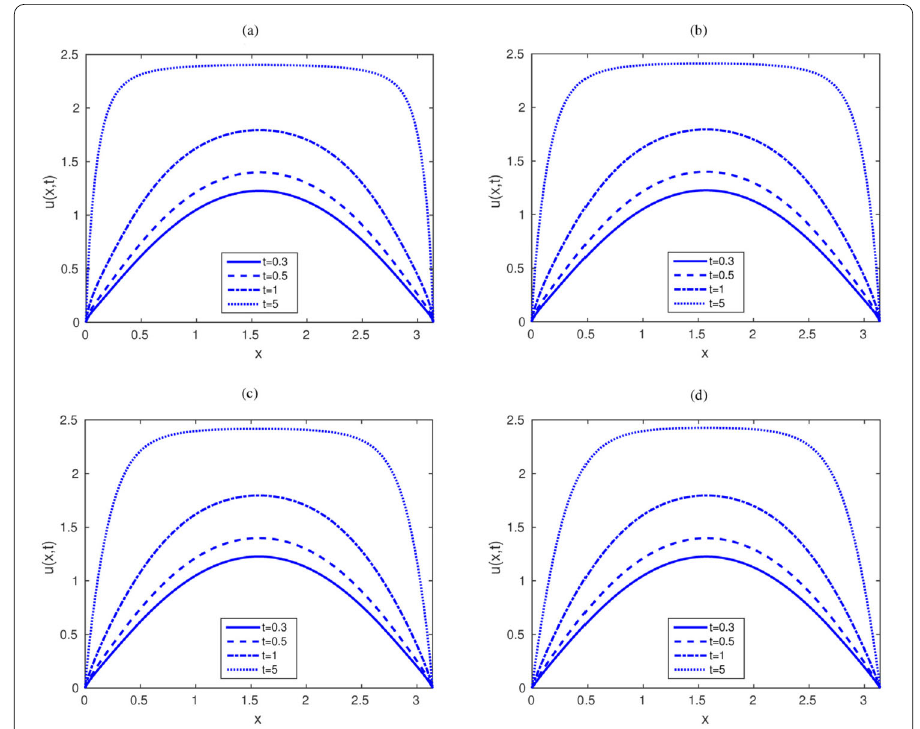
Figure 1 Approximate solution of the problem (57) using the DM method, at the times t = 0.3 (solid), 0.5 (dashed), 1 (dashed–dotted) and 5 (dotted). Various values of α were used, namely, ( a ) α = 1.2, ( b ) α = 1.4, ( c ) α = 1.6, and ( d ) α = 1.8. The solutions were calculated over Ω = (0, π ), and using K = 0.1. Computationally, we let h = π /200 and τ =